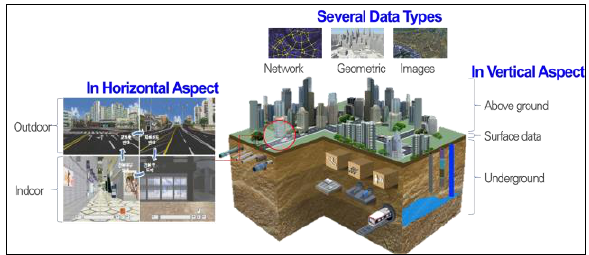
Figure 1. Various geospatial datasets according to representing the real